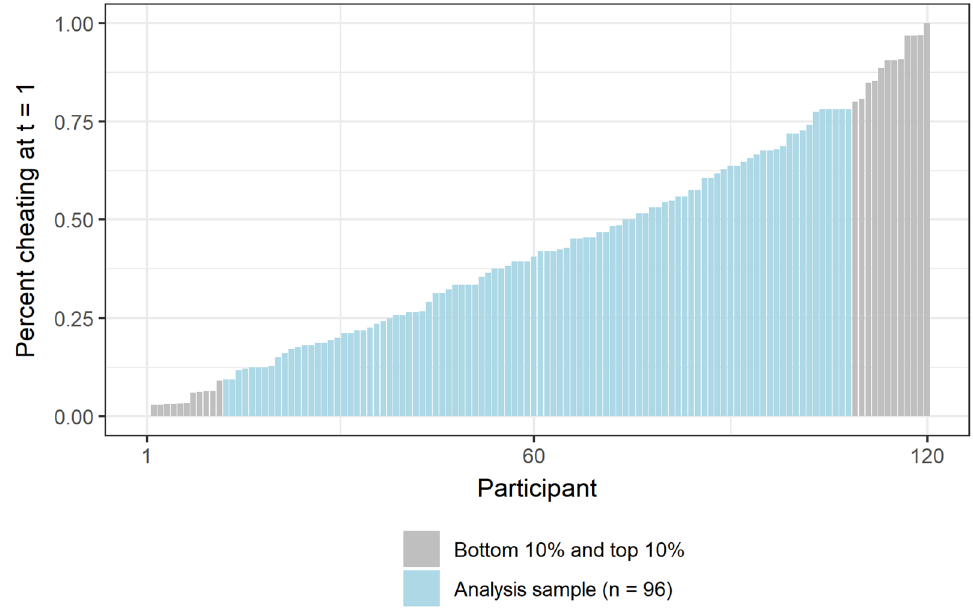
Figure 2. Observed cheating behavior in the first block of the SPOT. Participants are sorted based on the percent of trials they cheated, with the 10% most honest participants on the left side of the figure and the 10% most dishonest on the right side of the figure. On average, the 10% most honest participants cheated on 4% of trials (on average 1 trial out of 32), while the 10% most dishonest participants cheated on 90% of the trials (on average 29 out of 32